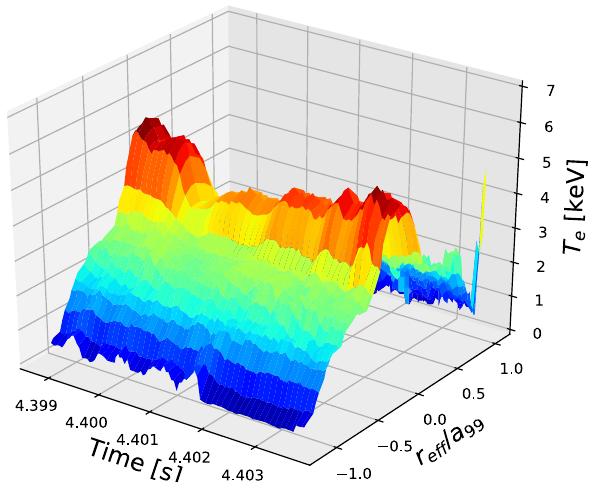
Figure 3. Time evolutions of the electron temperature profiles during the minor collapse of the e-ITB measured using the Thomson scattering with high-time resolution of 20 kHz repetition rate. Here, r eff / a 99 is the normalized coordinate, r eff is the effective minor radius, and a 99 is the minor radius of the flux surface enclosing 99% of the stored